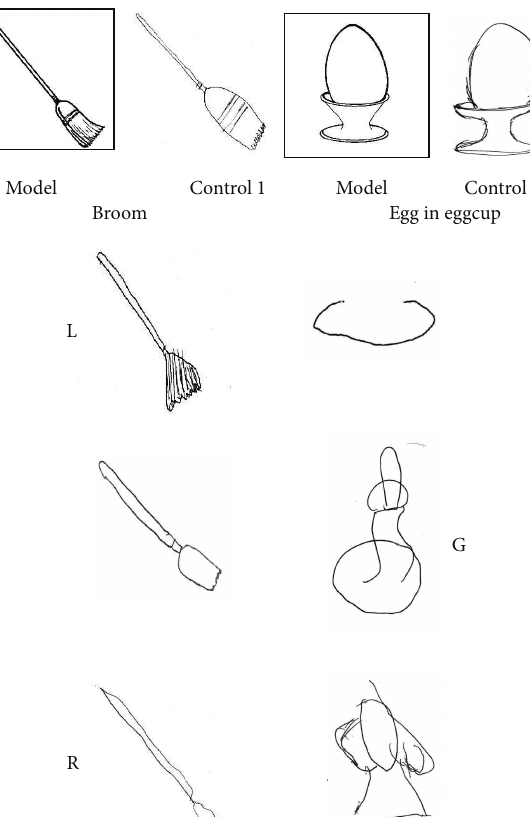
Figure 4: Two examples of immediate visual memory for objects performed by L., G., and R. The model is shown at the top, with the same object recalled by two neurological control subjects on the right. L., G., and R. had difficulties in reproducing the visual properties of each model and their drawings were limited at most to the typical representation of